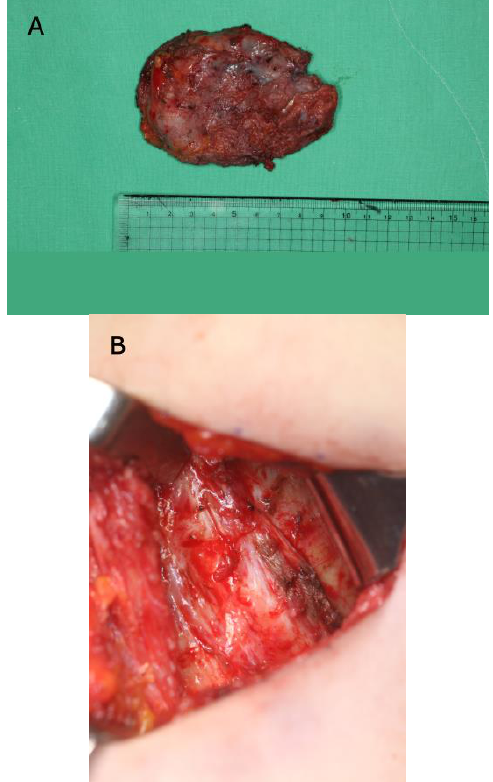
Figure 5. Intraoperative photographs during the second excision. ( A ) Excised mass. ( B ) Scapulotho- racic joint space after mass excision.